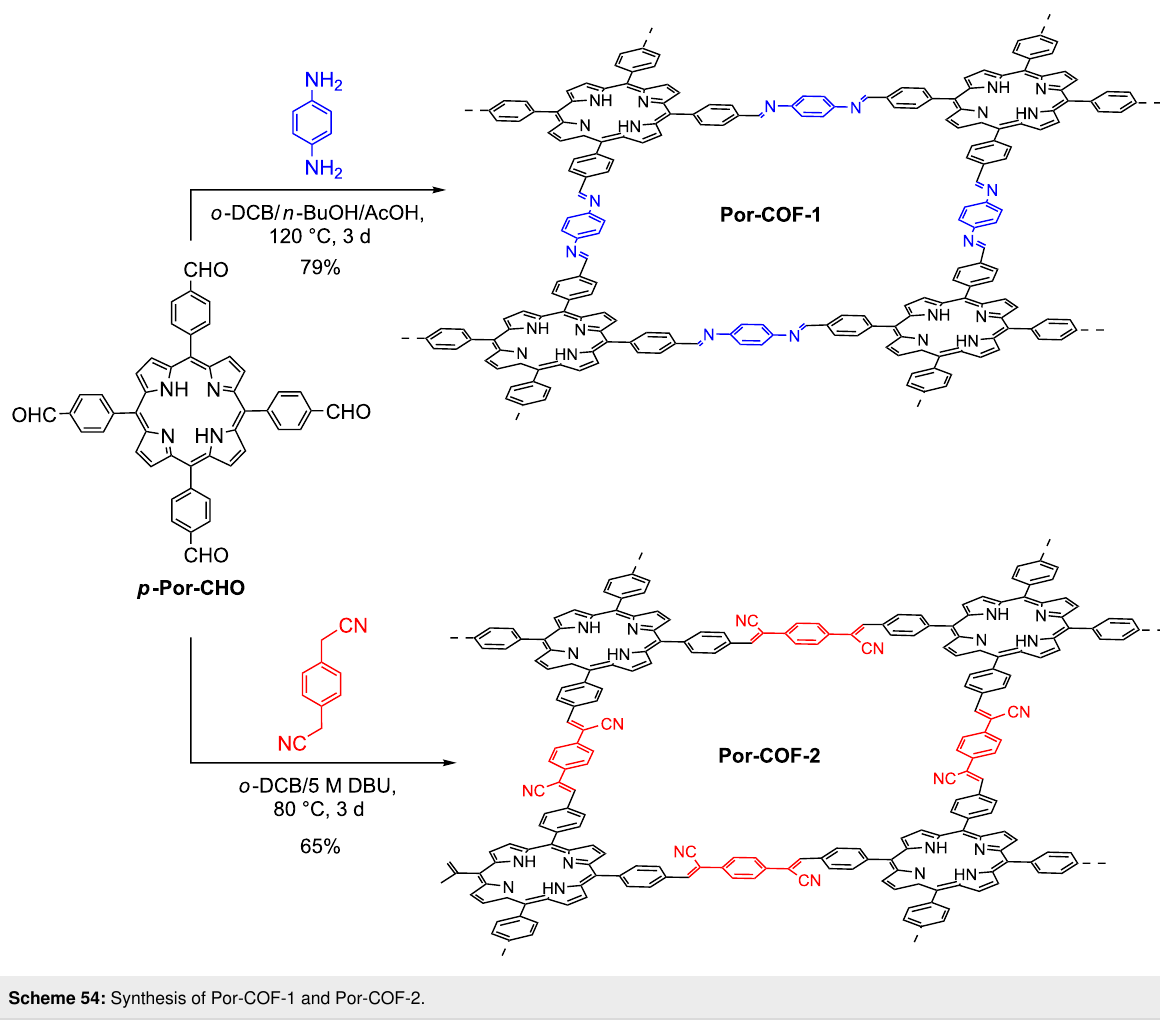
Scheme 54: Synthesis of Por-COF-1 and Por-COF-2.